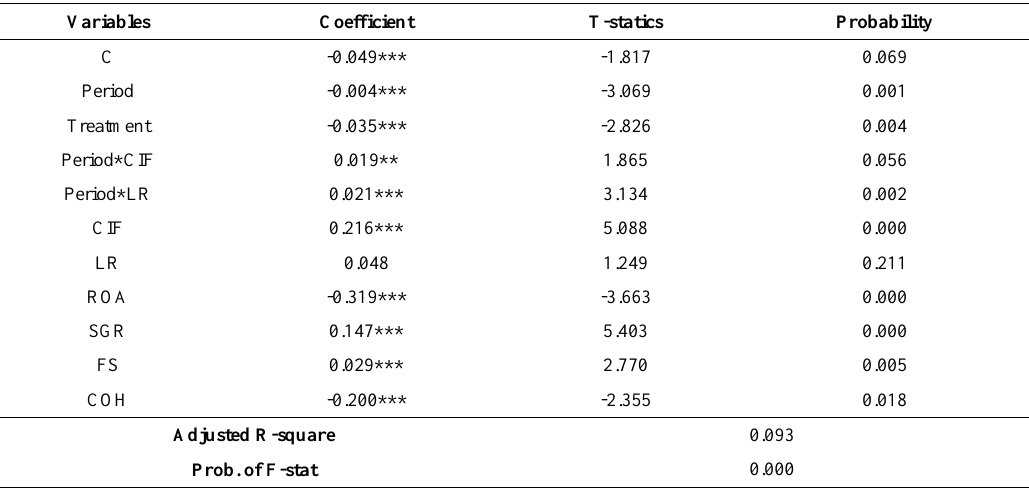
Table 6. Period Impact on Corporate Investment.